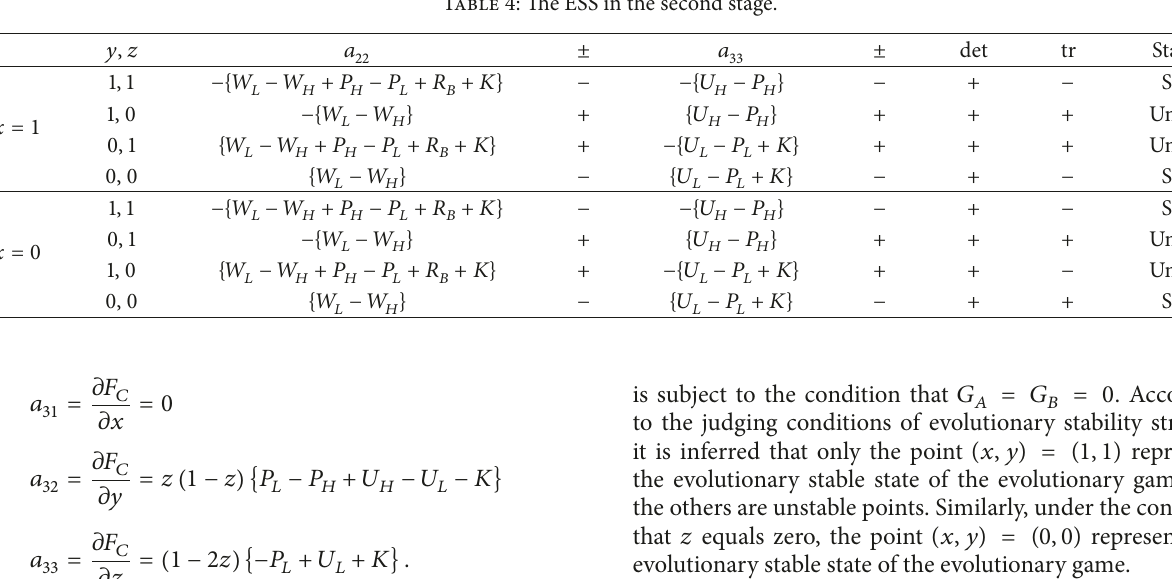
Table 4: The ESS in the second